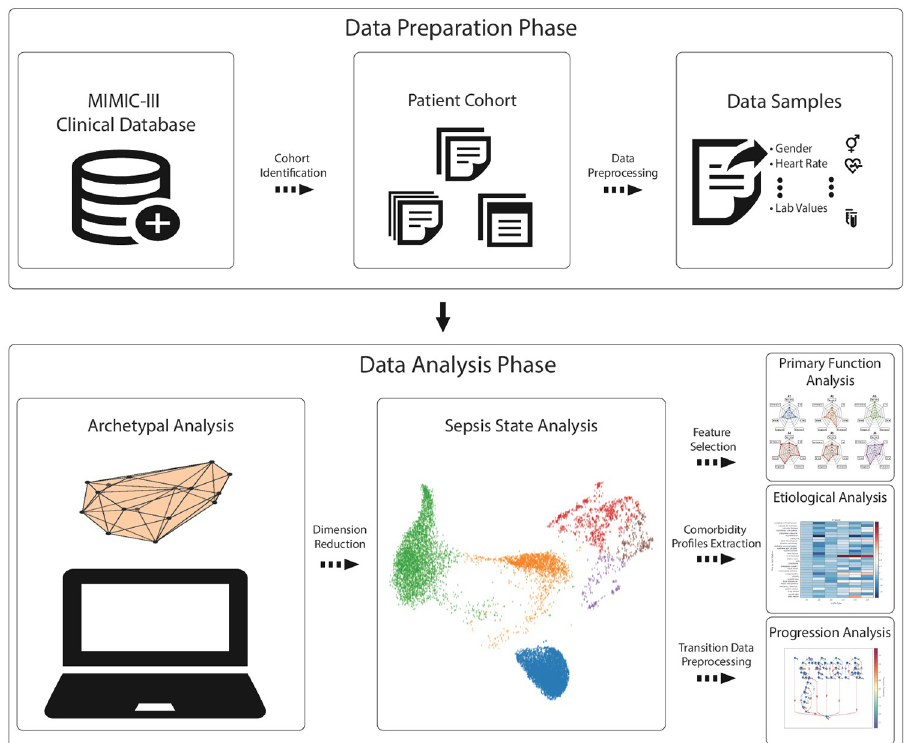
Fig 1. Illustration of proposed framework: The data preparation phase extracts 42 variables (demographic profiles, vital signs, laboratory tests, mechanical ventilation status of the patients, and the comorbidity profiles) from 16,546 distinct sepsis patients admitted to Beth Israel Deaconess Medical Center from the MIMIC-III database. In the data analysis phase, we use archetypal analysis to find distinct states in sepsis. We validate that each state corresponds to patient clusters that are statistically distinct from the distribution of the cohort as a whole, and the SOFA score, SIRS score, and mortality rate are calculated to characterize each sepsis state. In primary function analysis, selected features from archetypes are used to identify the primary functions (namely, nervous system, inflammation and infection, liver function, kidney function, coagulation, respiratory function, and, cardiovascular function ) of each sepsis state. In etiological analysis, we find correlation between pre-existing comorbidity profiles (30 types) and sepsis states. Finally, in progression analysis, we use higher-order Markov chains to model the dynamics of pathological processes of sepsis. We then use archetypal analysis to identify distinct types of sepsis state transitions and use z-score analysis to find representative clinical markers of each state transition.